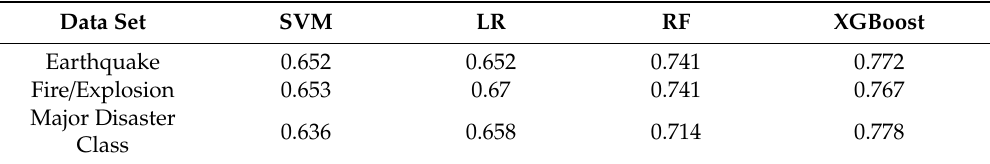
Table 5. F1 scores of subclass and major class predictions.